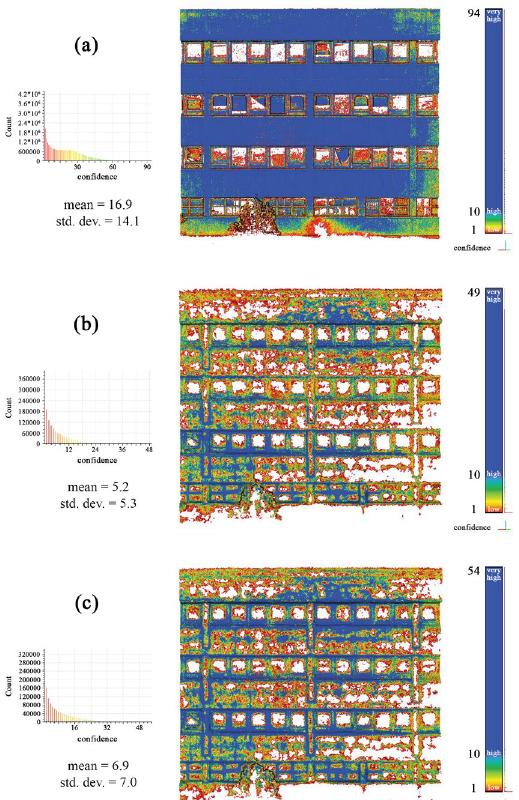
Figure 12 . C. Alvaro-P.Gobetti Comprehensive school point clouds confidence: (a) dense point cloud derived from visible dataset; (b) dense point cloud derived from thermal dataset (Workflow 1); (c) dense point cloud derived from thermal dataset (Workflow 2).